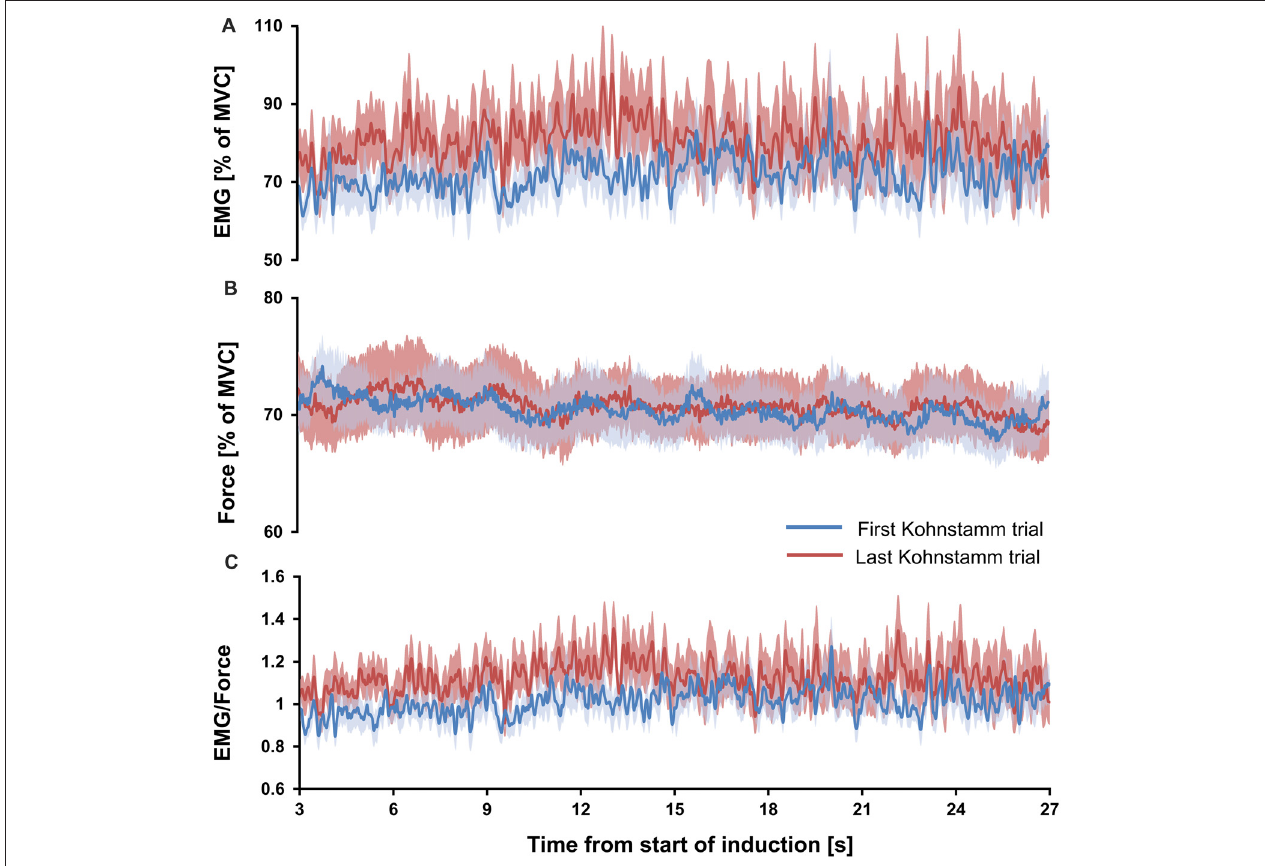
FIGURE 6 | Mean EMG, force and EMG/force during first and last Kohnstamm induction period. Mean EMG (% of MVC) recorded from the posterior deltoid during the Kohnstamm induction period for the first and last Kohnstamm trial (A) . Mean force (% of MVC) generated by an isometric contraction of the posterior deltoid during the Kohnstamm induction period for the first and last Kohnstamm trial (B) . Target force was 70% MVC. Mean EMG/Force during the Kohnstamm induction period for the first and last Kohnstamm trial (C) . Note that there was no significant increase in the ratio of EMG to Force produced from the start of each induction to the end, nor was there a significant increase when comparing the first to the last Kohnstamm